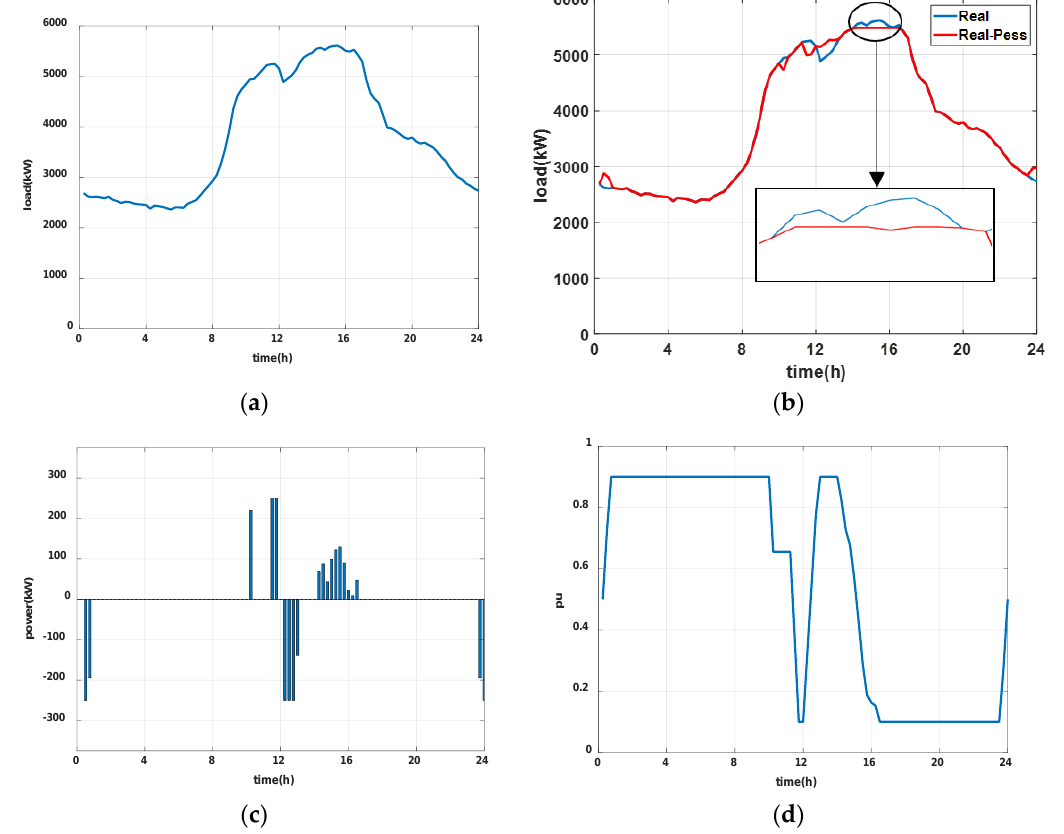
Figure 7. Case 1 simulation results. ( a ) Actual load on August 3; ( b ) comparison actual load with load after applying the two-stage algorithm; ( c ) ESS power; and ( d ) SOC.